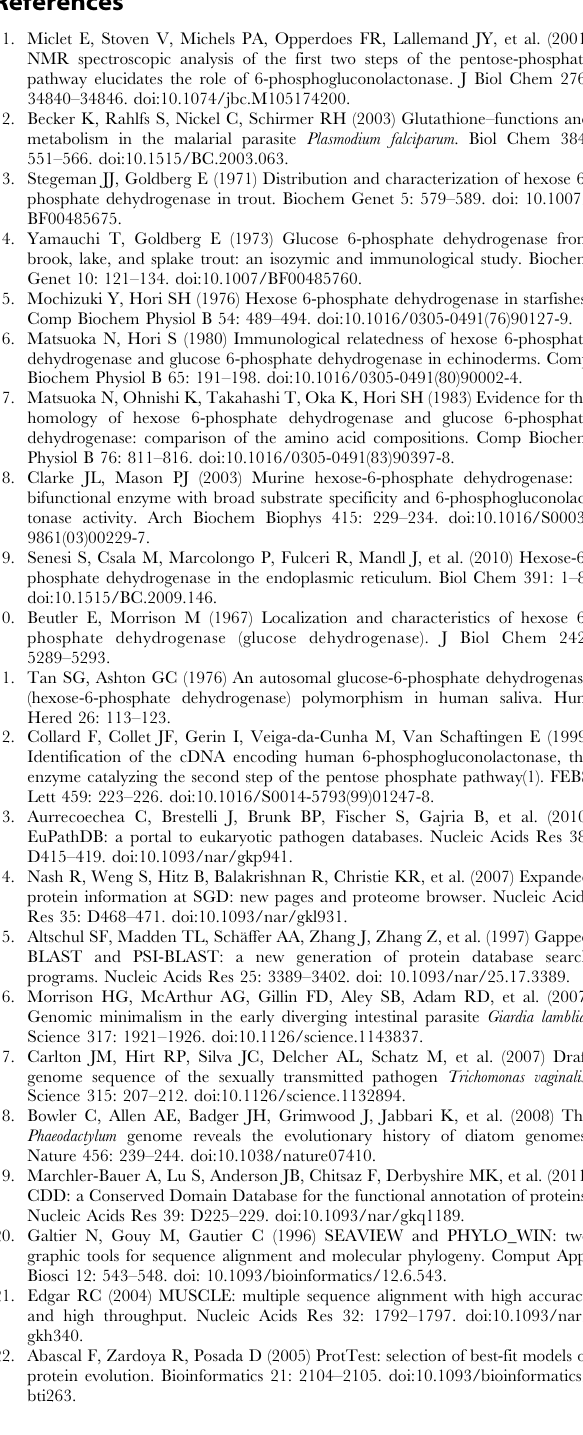
Table S1 List of all sequences used in this study. This file contains the list of all species analyzed together with the accession number and data source for each